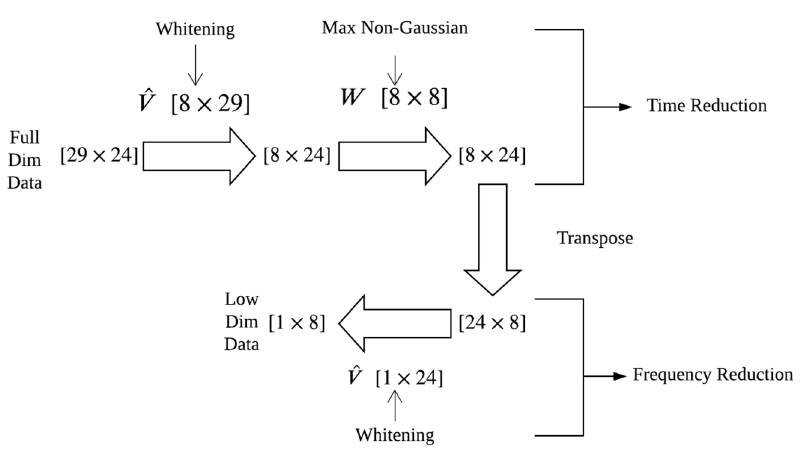
Figure 2. Computational steps of the proposed independent component analysis (ICA) approach.